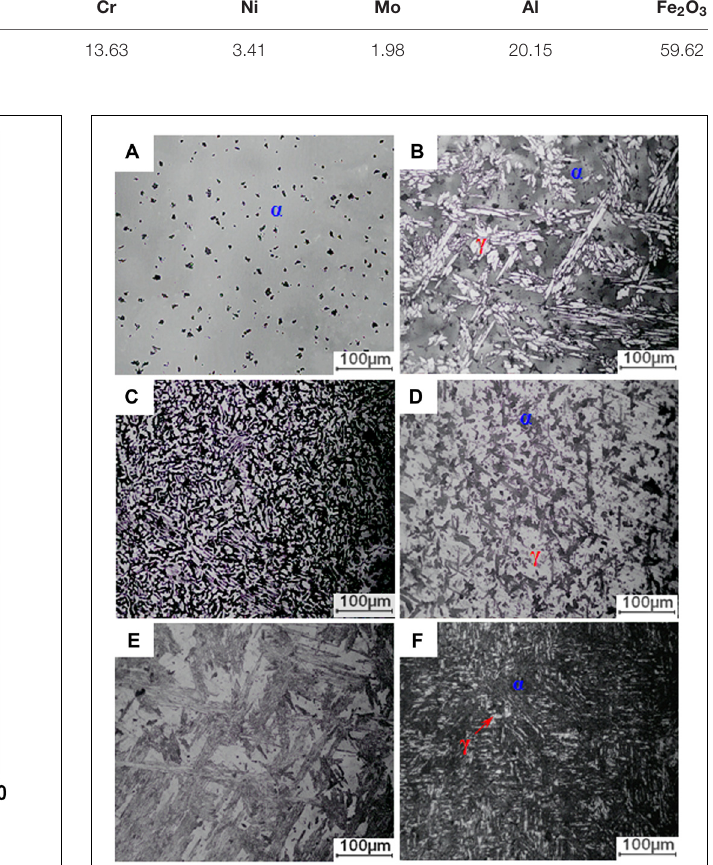
FIGURE 1 | X-ray diffractometer patterns of 2205 DSSs prepared with different Fe 2 O 3 excess percentages. was analyzed with an optical metallographic microscope (MeF3, Wetzlar, Germany), and the element distribution was observed using electron probe microanalysis (EPMA-1600, Kyoto, Japan).